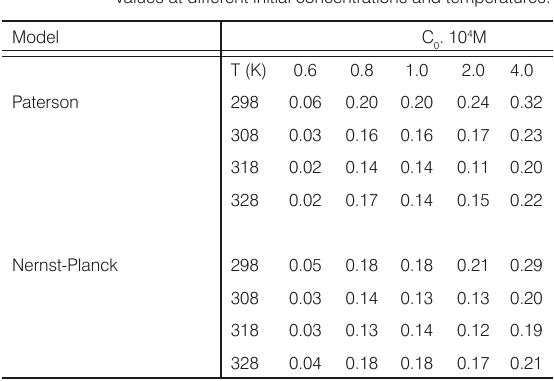
Figure 4. A comparison of experimental points with calculated U values according to Paterson and Nernst-Planck (inset figure) models at 328 K. Table 5. Standard deviations between observed and calculated U values at different initial concentrations and temperatures.